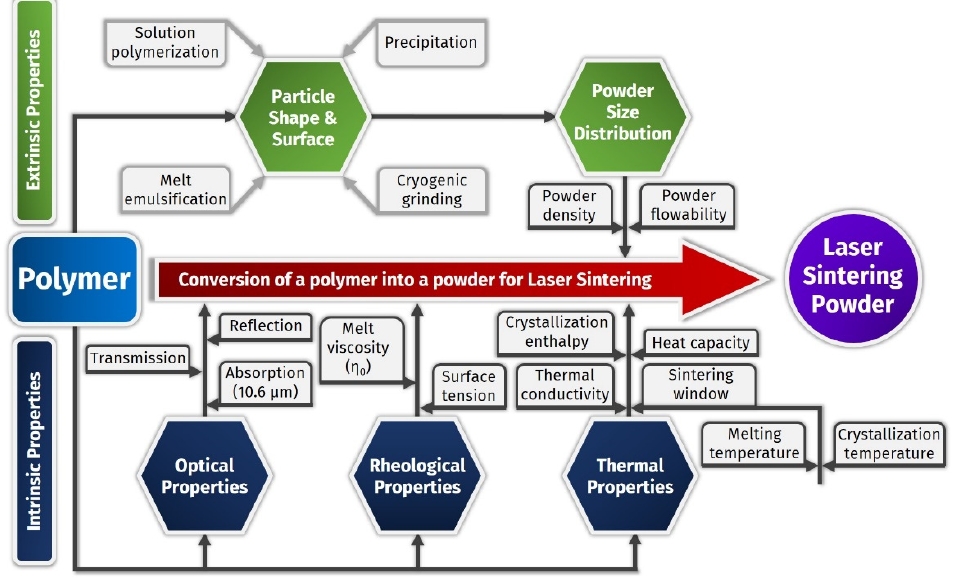
Figure 1. Critical properties for a polymer laser sintering material. Adapted with permission from Schmid et al. [5].